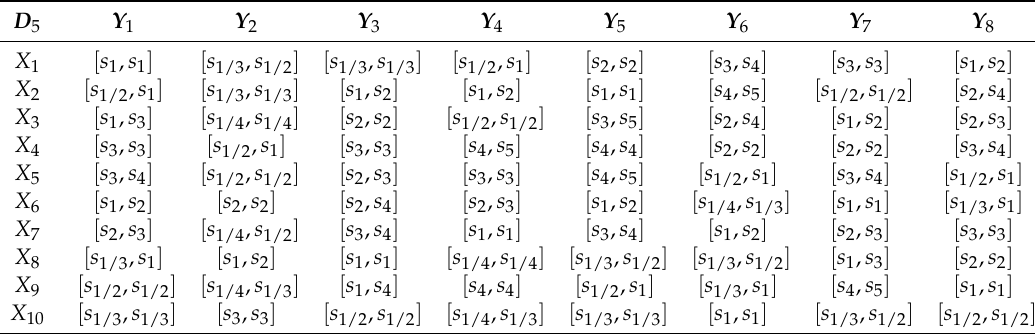
Table A5. Linguistic evaluation information matrix of D 5 .